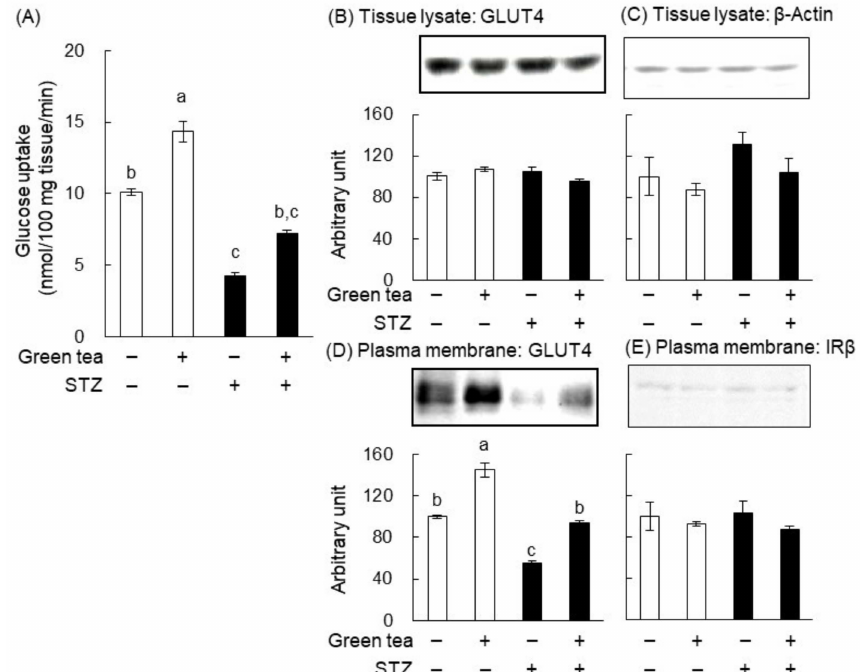
Figure 4. Green tea consumption increased glucose uptake and glucose transporter 4 (GLUT4) translocation in the skeletal muscle of STZ-induced T1DM rats. Rats were treated as described in Figure 1A. At the end of the treatment, the rats were administered glucose (2 g / kg body weight) and were sacrificed 1 h later. Skeletal muscle was cut into small pieces of 50 mg each, and 3- O -methyl-D-[1- 3 H] glucose (3-OMG) uptake was measured ( A ) as described in “Materials and Methods”. The expressions of GLUT4 and β -actin in tissue lysates ( B , C ) and the quantities of GLUT4 and the β -subunit of the insulin receptor (IR β ) present in the plasma membrane fractions ( D , E ) were determined by western blotting analysis, as described in “Materials and Methods”. In ( B – E ), the upper panels show typical immunoblots and the lower panels show the density of each band for all rats ( n = 5). Data are expressed as the means ± SE. Values sharing the same letters were not significantly di ff erent (Tukey–Kramer multiple comparison test; p <